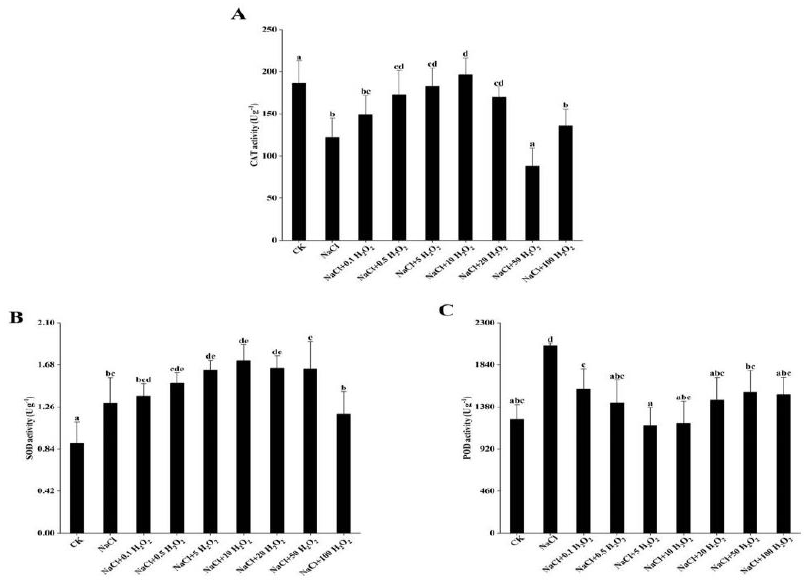
Figure 3. Effect of H 2 O 2 pretreatment on the activity of CAT ( A ), SOD ( B ), and POD ( C ) in F. tatari- cum seedlings under NaCl stress. CK, control treatment (only water); NaCl, 50 mmol L − 1 NaCl treatment; NaCl + xxx H 2 O 2 , treatments of standard NaCl + respective H 2 O 2 concentration; CAT, catalase (U g −1 ); SOD, superoxide dismutase (U g −1 ); POD, peroxidase (U g −1 ). Different lowercase letters on each column indicate significant differences between treatments at p <